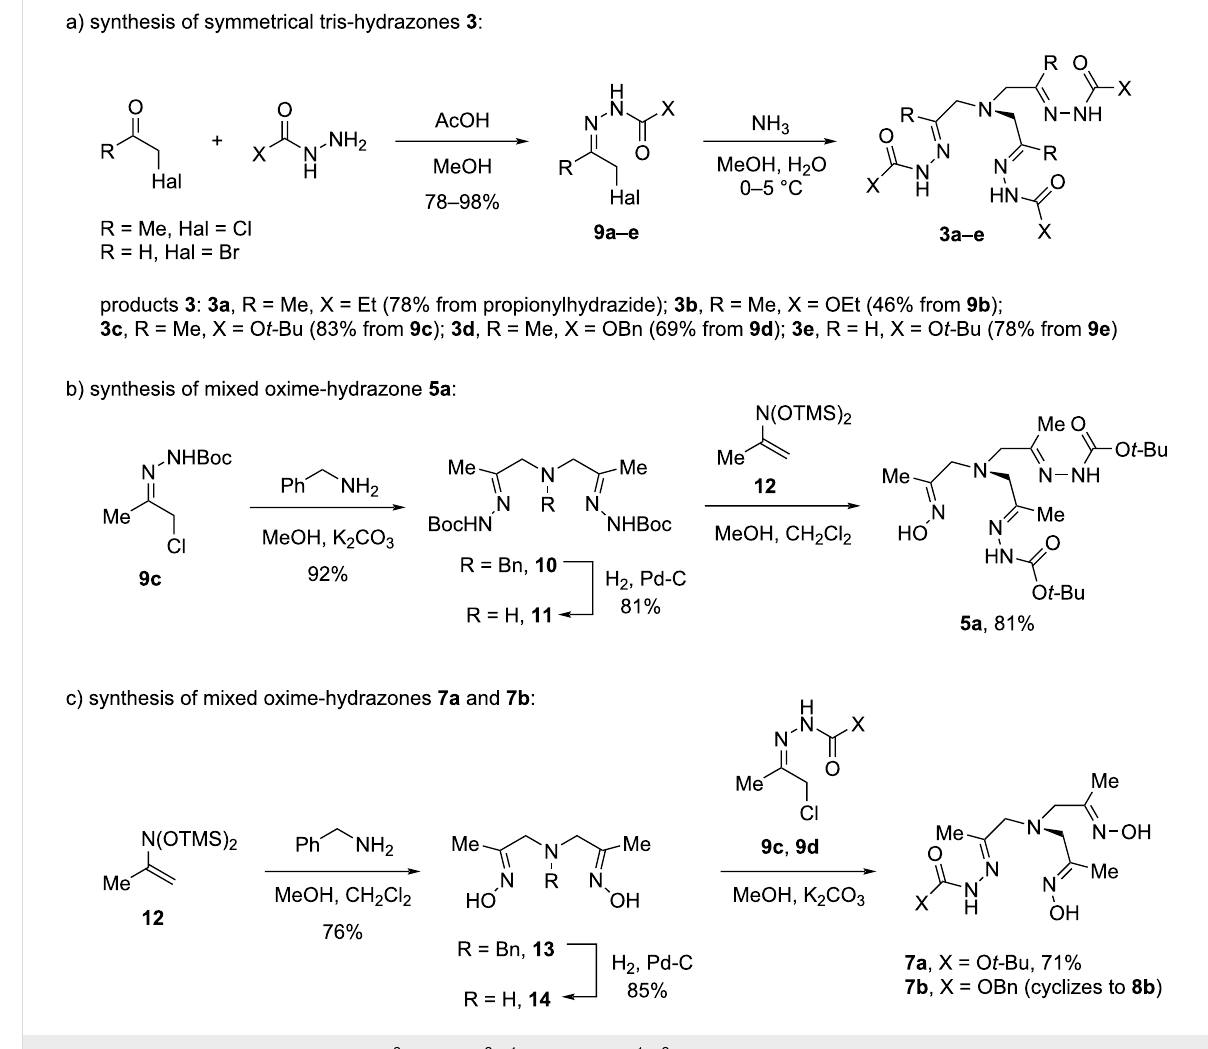
Scheme 2: Synthesis of acyclic precursors to 3 N -TAADs, 2 N, 1 O -TAADs, and 1 N, 2 O -TAADs.